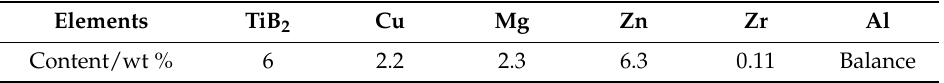
Table 1. Nominal chemical composition of TiB 2 /7050 Al composite.